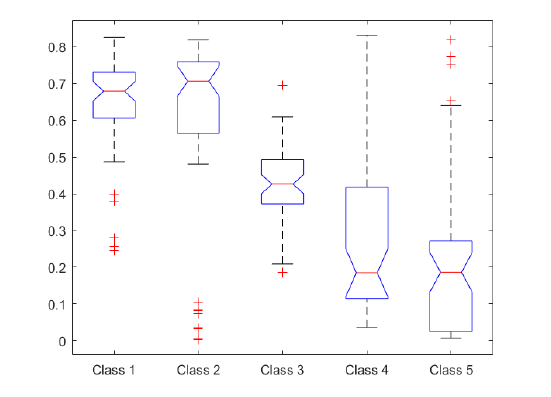
Figure 8. Boxplot of Beta Coefficient Variations in Five Classes